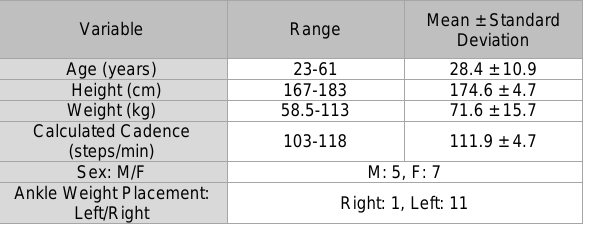
Table 1: Participant